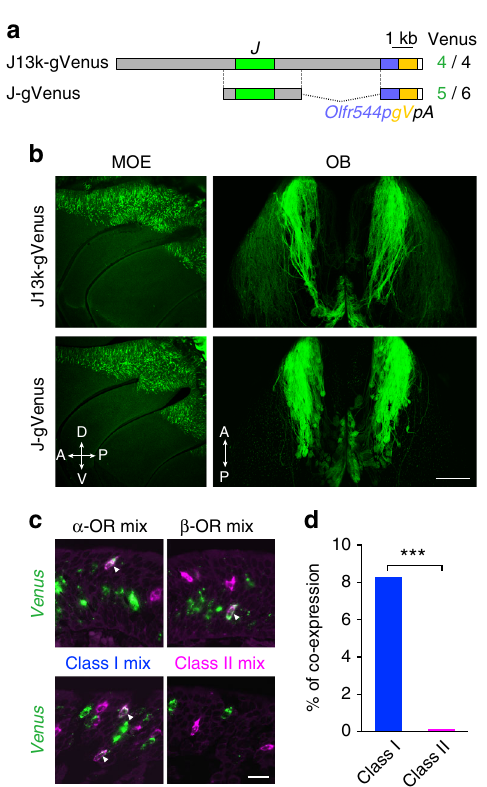
Fig. 3 The J element possesses class I OSN-speci fi c enhancer activity. a Transgenes of J13k-gVenus and J-gVenus. The number of Venus-positive independent founders and lines among the total analyzed is shown on the right. Olfr544p , promoter region of Olfr544 ; gV , membrane-targeted Venus reporter ( gapVenus ); pA , polyadenylation sequence. b Whole-mount fl uorescent images of the MOE and the dorsal OB of hemizygous J13k-gVenus Tg mice and J-gVenus Tg mice. The scale bar is 500 μ m. c Confocal images of two-color ISH of Venus ( green ) with mixed probes of α = − class I OR genes, β = class I OR genes, class I OR genes, and class II OR genes ( magenta ) in a J-gVenus Tg mice. Enhancer activity of the J element ( Venus ) was observed in class I OR-positive cells ( arrowheads ). The scale bar is 20 μ m. d Bar graphs showing the percentage of Venus -positive cells that are labeled with the class I or class II OR mixed probes (3112 cells for class I, 3252 cells for class II probes from 3 mice). Co-expression preferentially occurred in class I OR-expressing OSNs. Fisher ’ s exact